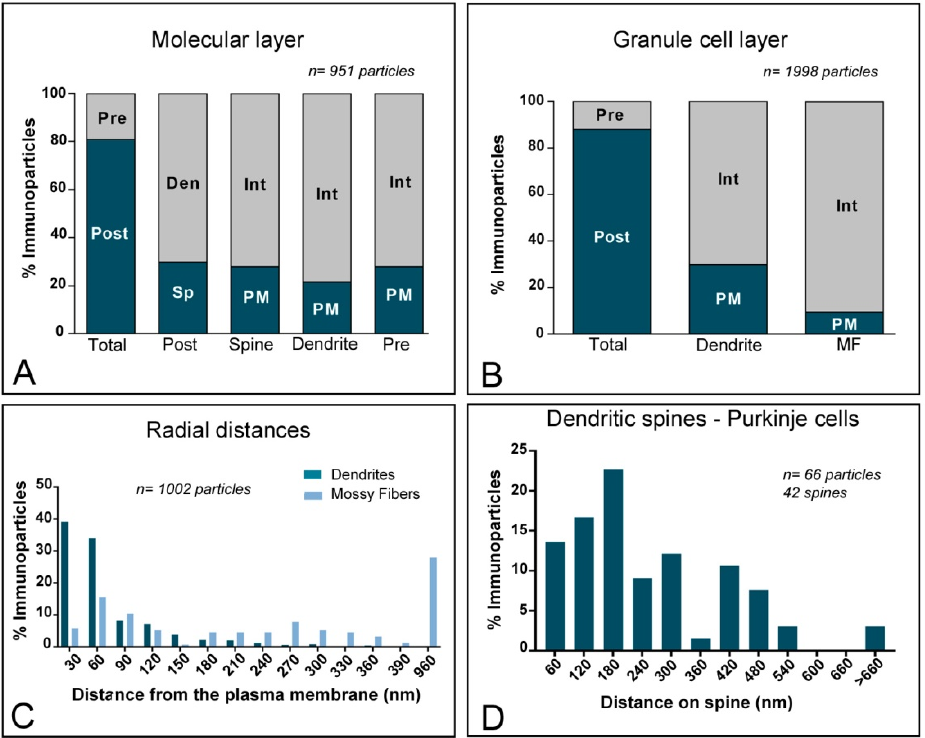
Figure 6. Compartmentalisation of Kv channel interacting protein (KChIP) subunit KChIP4 in cerebellar cells. ( A ) Bar graphs showing the percentage of immunoparticles for KChIP4 at post- and pre-synaptic compartments in the molecular layer. A total of 951 immunoparticles in the molecular layer were analysed, of which 80.9% were postsynaptic and 19.1% were presynaptic. Postsynaptically, immunoparticles were detected in dendritic spines (29.8%) and in dendritic shafts (70.2%), distributed along the plasma membrane (27.9% in spines; 21.5% in dendrites) and at cytoplasmic sites (72.1% in spines; 78.5% in dendrites). ( B ) Bar graphs showing the percentage of KChIP4 immunoparticles at post- and pre-synaptic compartments, and along the plasma membrane and intracellular sites in dendritic shafts of granule cells and mossy fibres in the granule cell layer. A total of 1998 immunoparticles in the granular cell layer were analysed, of which 87.9% were postsynaptic and 12.1% were presynaptic. Postsynaptically, immunoparticles were detected in dendrites of GCs (87.9%), distributed along the plasma membrane (29.9%) and at cytoplasmic sites (70.1%). Presynaptically, immunoparticles were detected in mossy fibre terminals (12.1%), distributed mostly at cytoplasmic sites (90.4%) and very few along the plasma membrane (9.6%). ( C ) Histogram showing the radial distribution of KChIP4 immunoparticles from the plasma membrane towards cytoplasmic sites in dendrites of GCs and mossy fibres. In dendrites, immunoparticles for KChIP4 showed a skewed frequency distribution in the plasma membrane direction, but in mossy fibres, they were more equally distributed across the axoplasm. ( D ) Histogram showing the distribution of immunoreactive KChIP4 in relation to glutamate release sites in dendritic spines PCs. The data show the proportion of KChIP4 immunoparticles at a given distance from the edge of the postsynaptic density. About 74.2% of immunolabelled KChIP4 are located in a 60–300 nm wide band, and then the density decreased markedly further in the spine membrane.